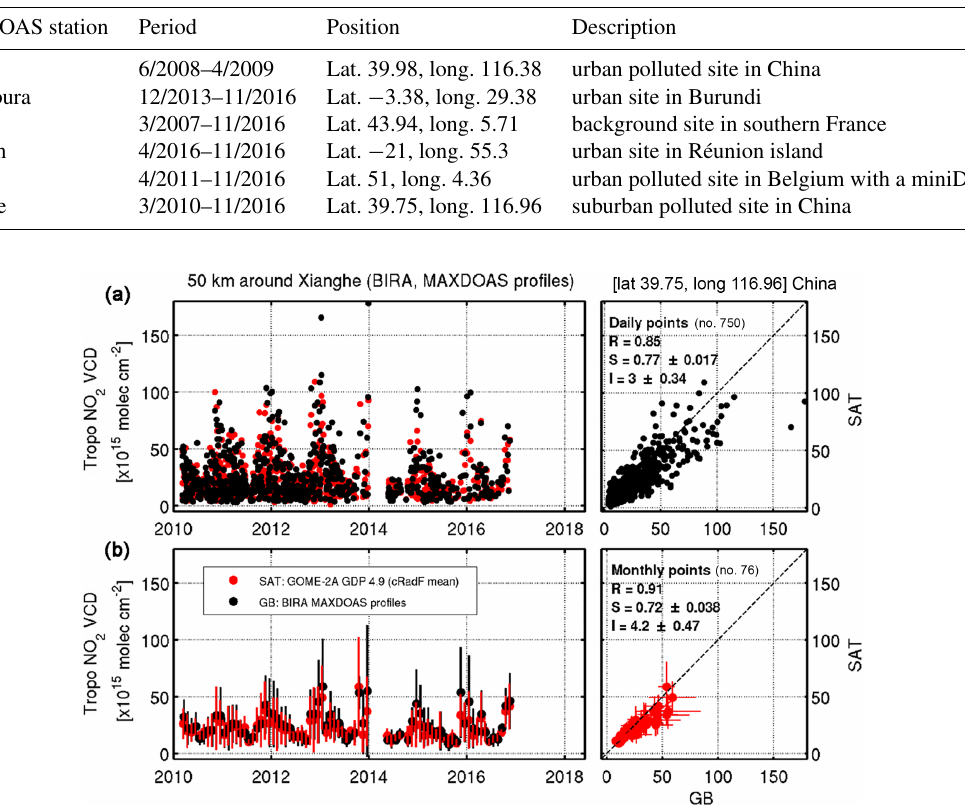
Figure 16. Daily (a) and monthly mean (b) time series and scatter plots of GOME-2A and MAXDOAS tropospheric NO 2 columns (mean value of all the pixels within 50km around